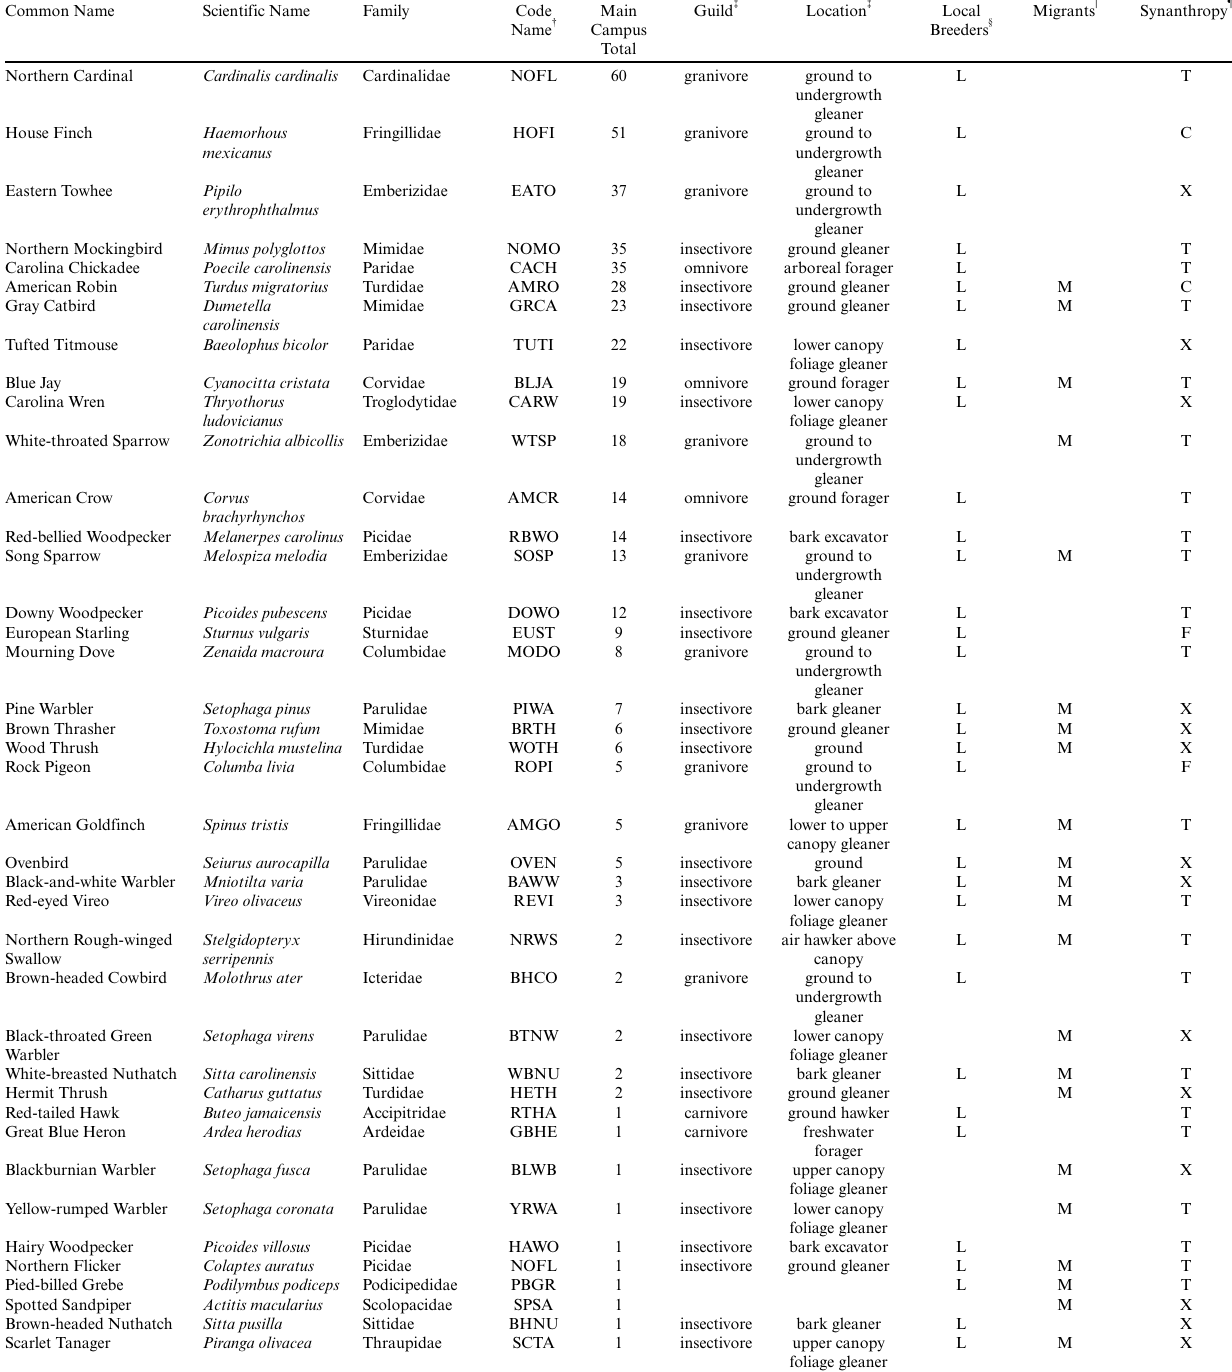
Table 2 . Total observations of each species from point counts during spring and fall 2015 at Duke